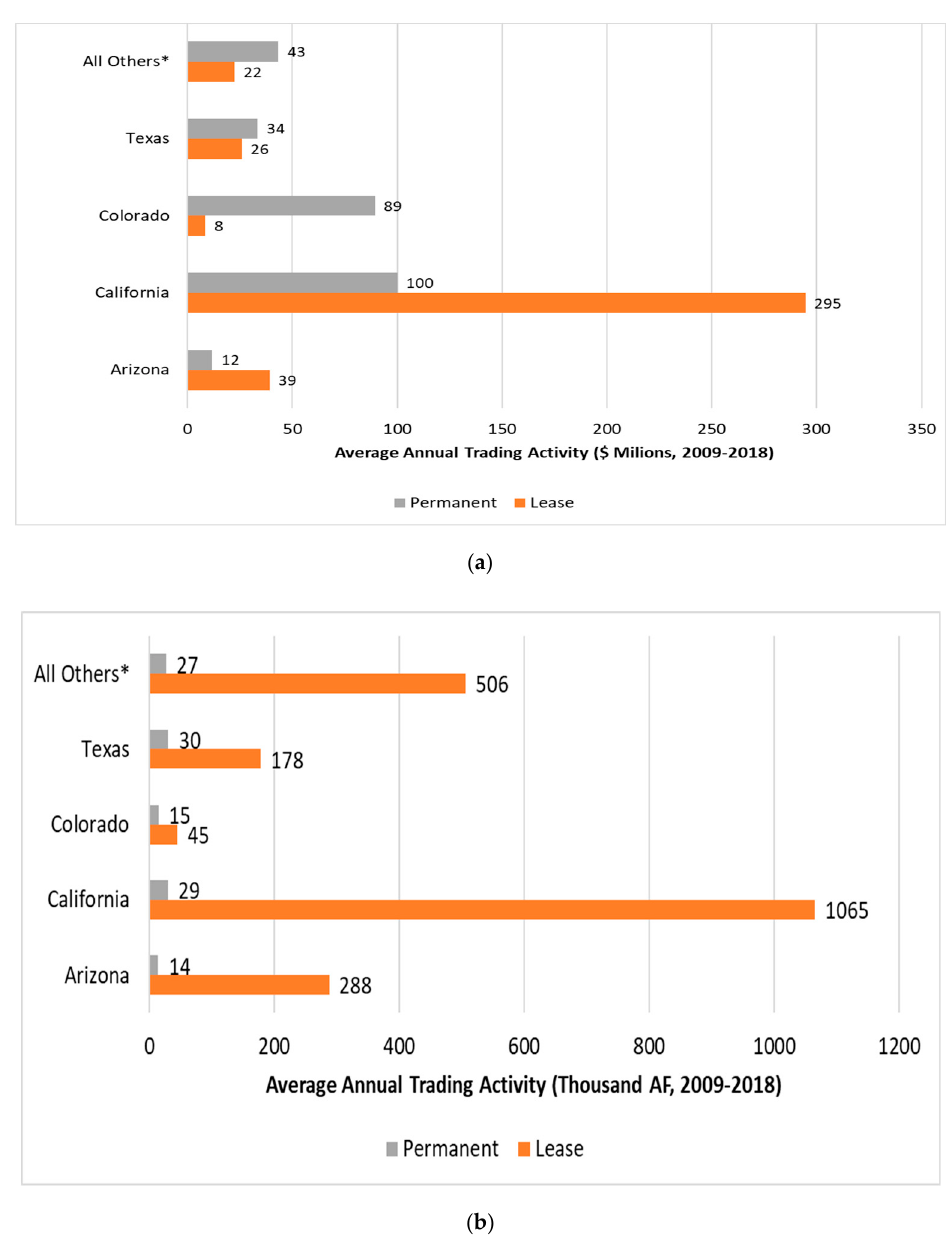
Figure 5. Average annual trading activity by state and trade type (2009–2018). ( a ) Average annual trading activity ($ Milions, 2009-2018); ( b ) Average annual trading activity (Thousand AF, 2009–2019);